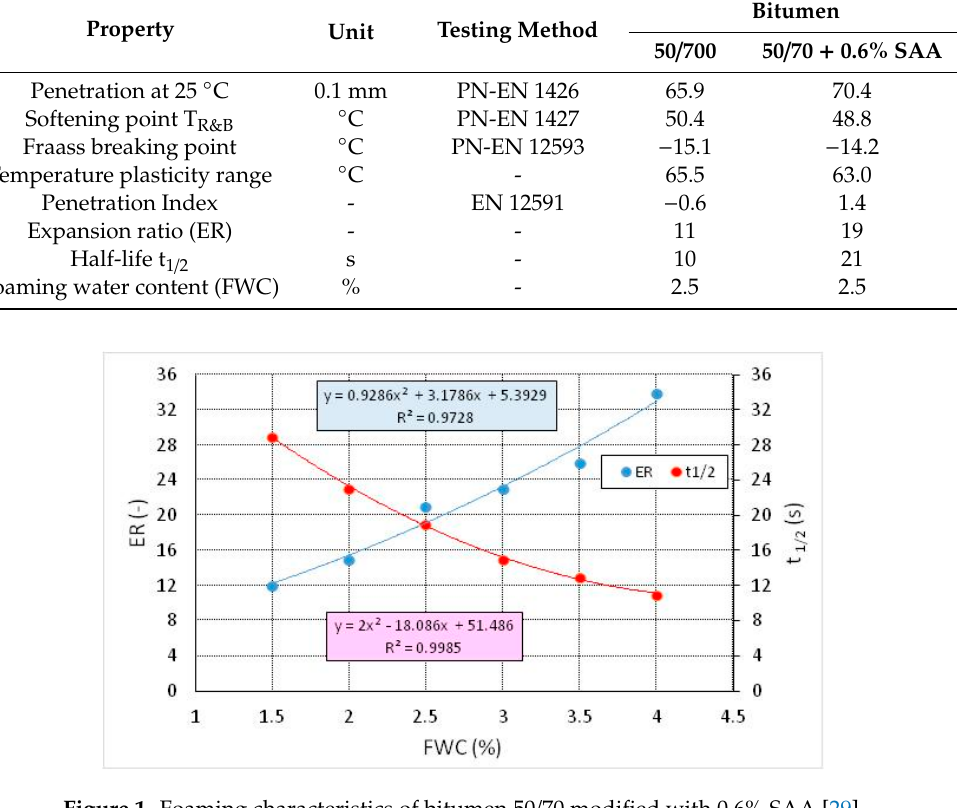
Figure 1. Foaming characteristics of bitumen 50/70 modified with 0.6% SAA [29].